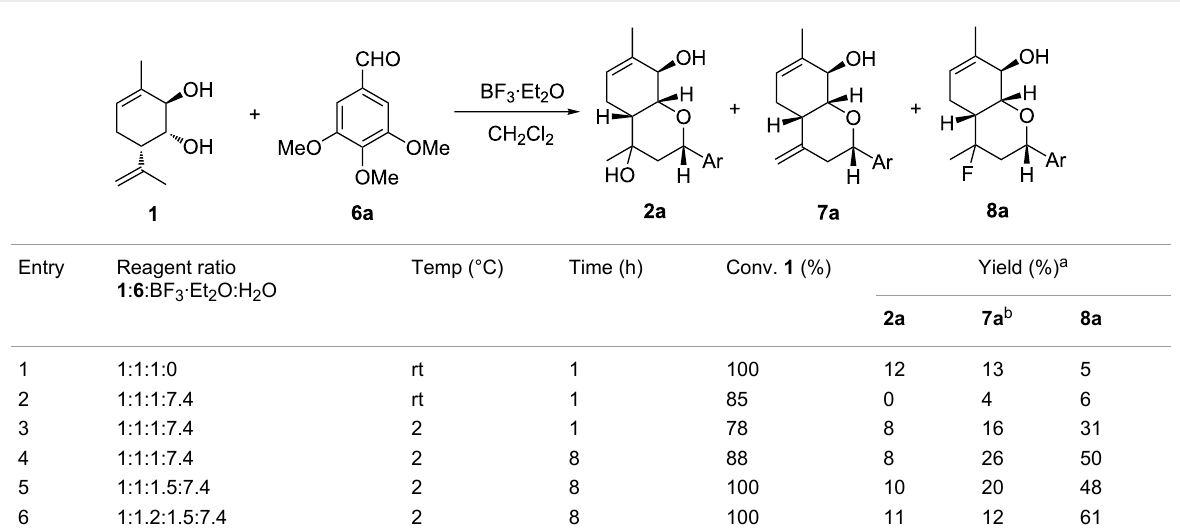
Table 1: The variation of reaction